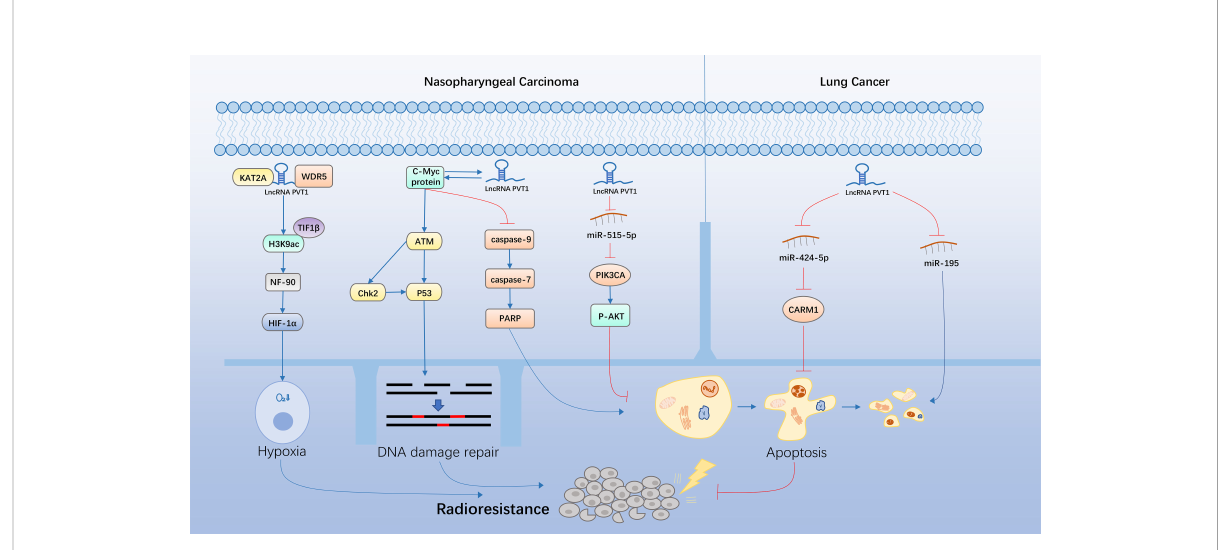
FIGURE 5 Molecular mechanisms underlying the lncPVT1-induced regulation of cancer